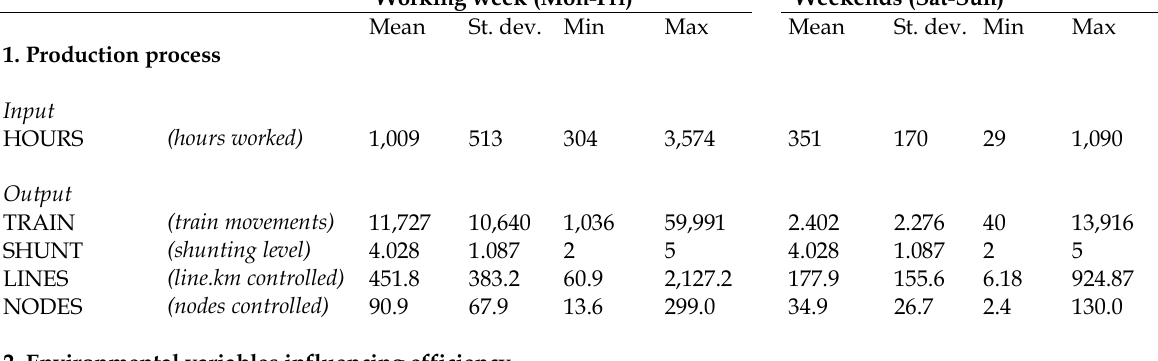
Table 2. Descriptive